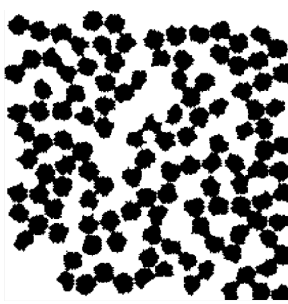
Figure 9. Cross-section of the generated carbon aerogel structure obtained from the generated structure 13.